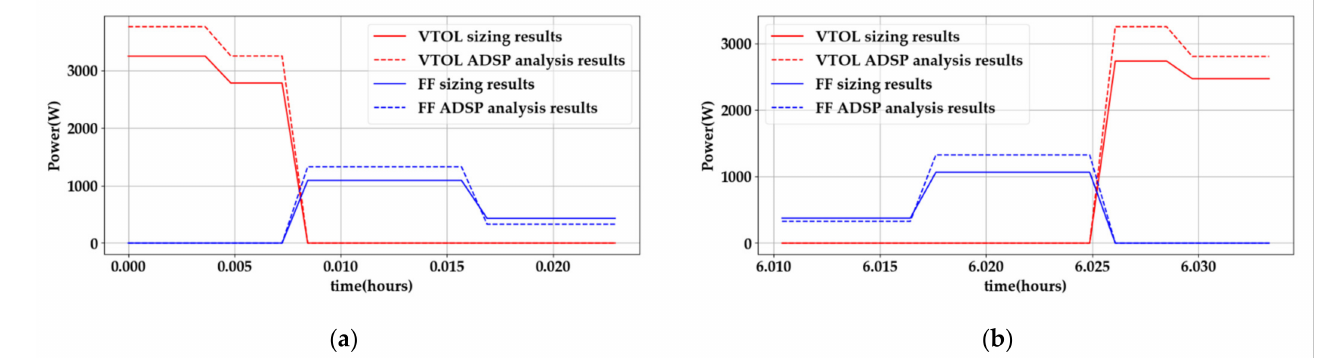
Figure 19. Required power of each mission segment: ( a ) the required power from vertical take-off to cruising; ( b ) the required power from cruising to vertical landing.